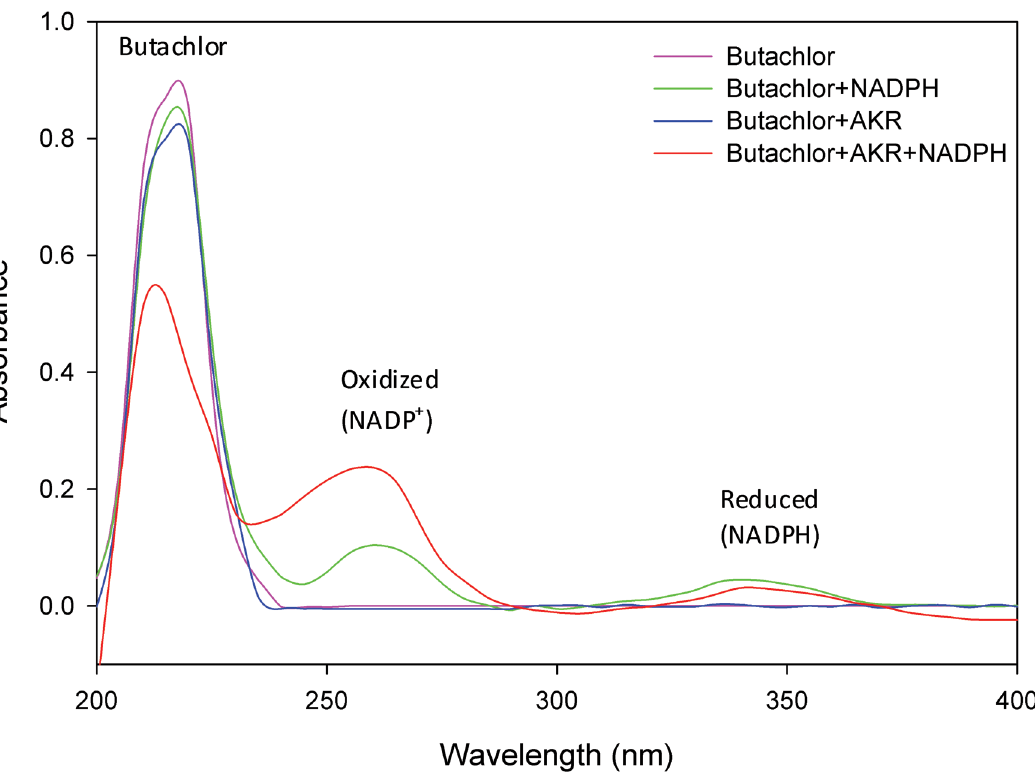
Fig 7. Absorption spectrograms showing degradation of butachlor by NADPH dependent AKR17A1. The analysis was performed in triplicates. The absorption spectra for each samples was recorded in 1 mL sample volume containing 50 mM potassium phosphate buffer (pH 7.4), 10 mM β - mercaptoethanol, 0.1 mM butachlor and either 0.12 mM NADPH, 5 μ g AKR or